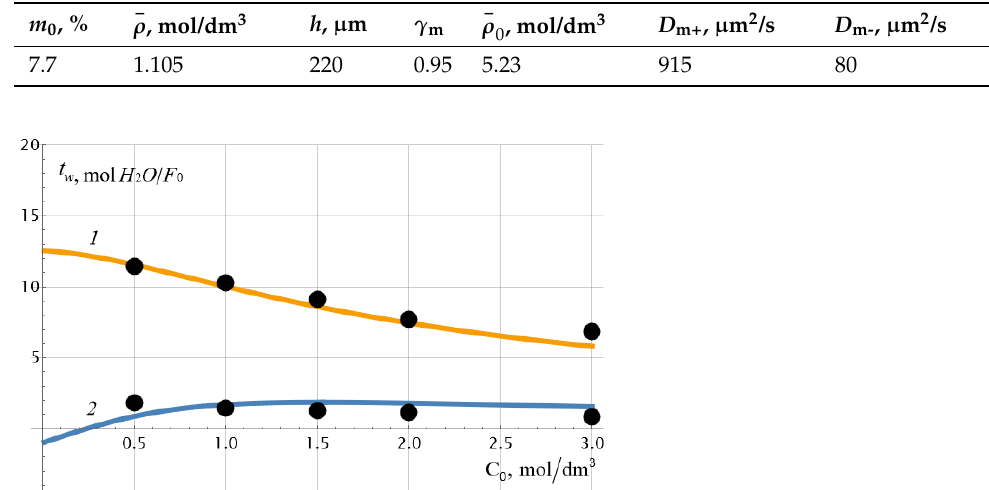
Figure 4. Theoretical values of the true osmotic permeability L 13 of the MF − 4SC membrane depend on the equilibrium concentration of an aqueous solution of NaCl.